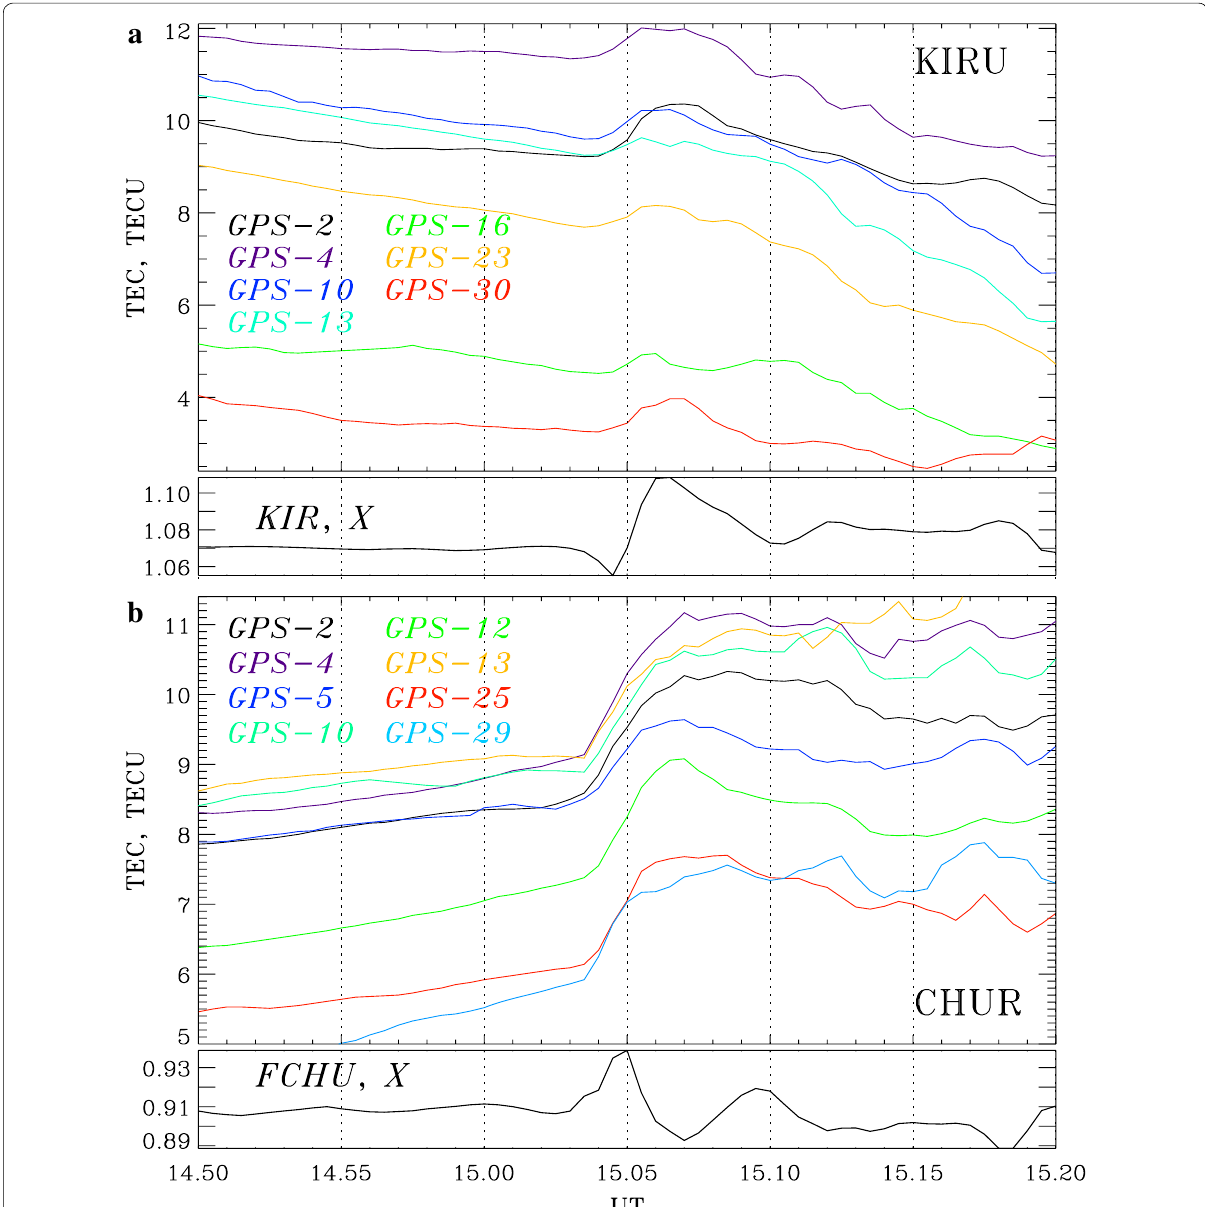
Fig. 11 a The vTEC data (in TECu) from satellites with α > 15° in the Scandinavian sector from the KIRU GPS receiver for various GPS satellites (PRN#02, 04, 05, 10, 12, 13, 25, 29, 31) during the time period 1450–1520 UT. Bottom panel shows magnetic variations from station KIR (X-com- ponent in [10 4 nT]); b vTEC data (in TECu) from satellites with α > 15° in the Canadian sector from the CHUR GPS receiver for various GPS satellites (PRN#02, 04, 10, 13, 16, 23, 30). Bottom panel shows magnetic variations from station FCHU (X-component in 10 4 nT). Location of the ionospheric pierce points during the SC is shown in Fig.